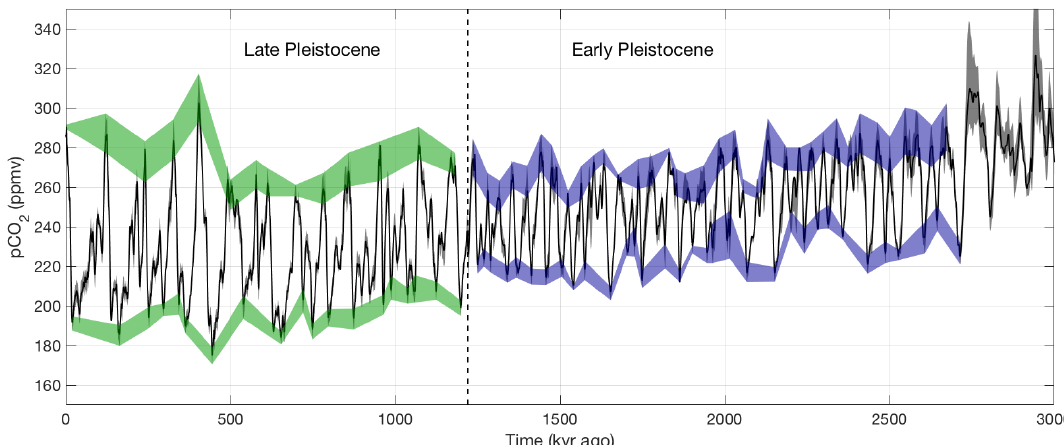
Figure 7. Reconstructed atmospheric CO 2 during the Pleistocene. The coloured regions indicate the glacial and interglacial ranges for the Early (2.6–1.2Myr ago; blue) and Late (1.2–0.011Myr ago; green)